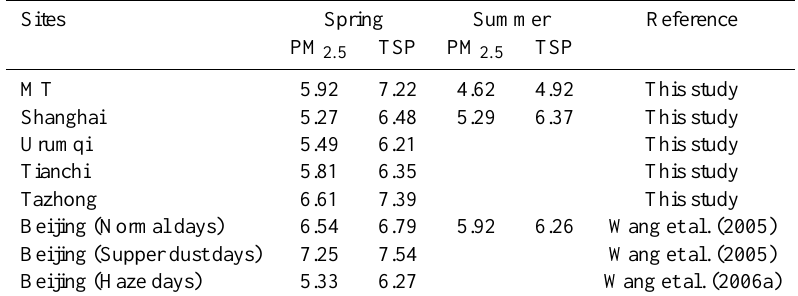
Table 7. pH of aqueous filtrates of PM 2 . 5 and TSP aerosols at different sampling sites. Sites Spring